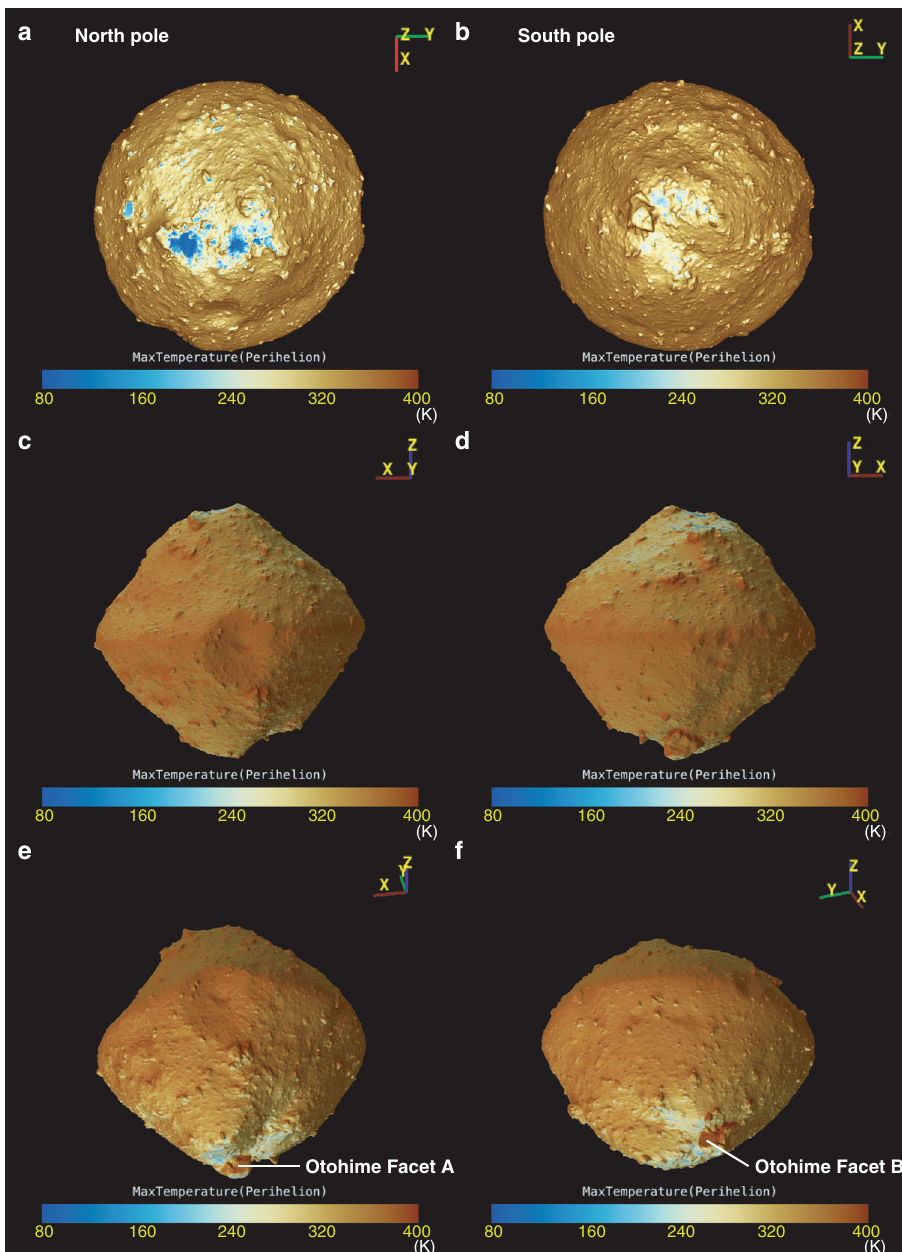
Fig. 5 Global distribution of maximum surface temperature at perihelion. a , b are nadir views from the north and south poles. c, d are the views from (LAT, LON) = (0°, 90°) and (0°, 270°), respectively. e , f are the views from ( − 30°, 100°) and ( − 30°, 200°) to show Facets A and B of Otohime Saxum. Maximum temperature shows low values at the north pole <100 K. However, Otohime shows high surface temperatures even on the pole due to the high incidence angles towards the